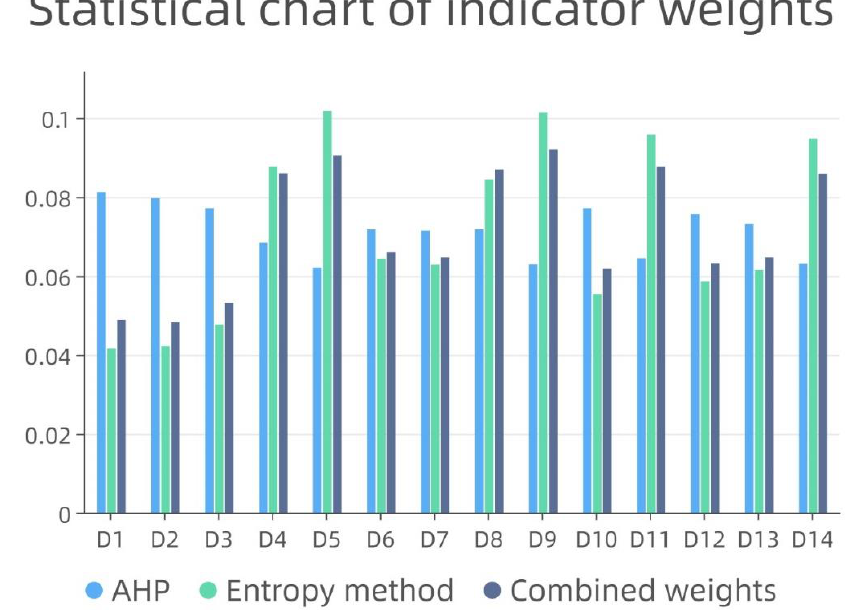
Figure 4. Weight value chart.